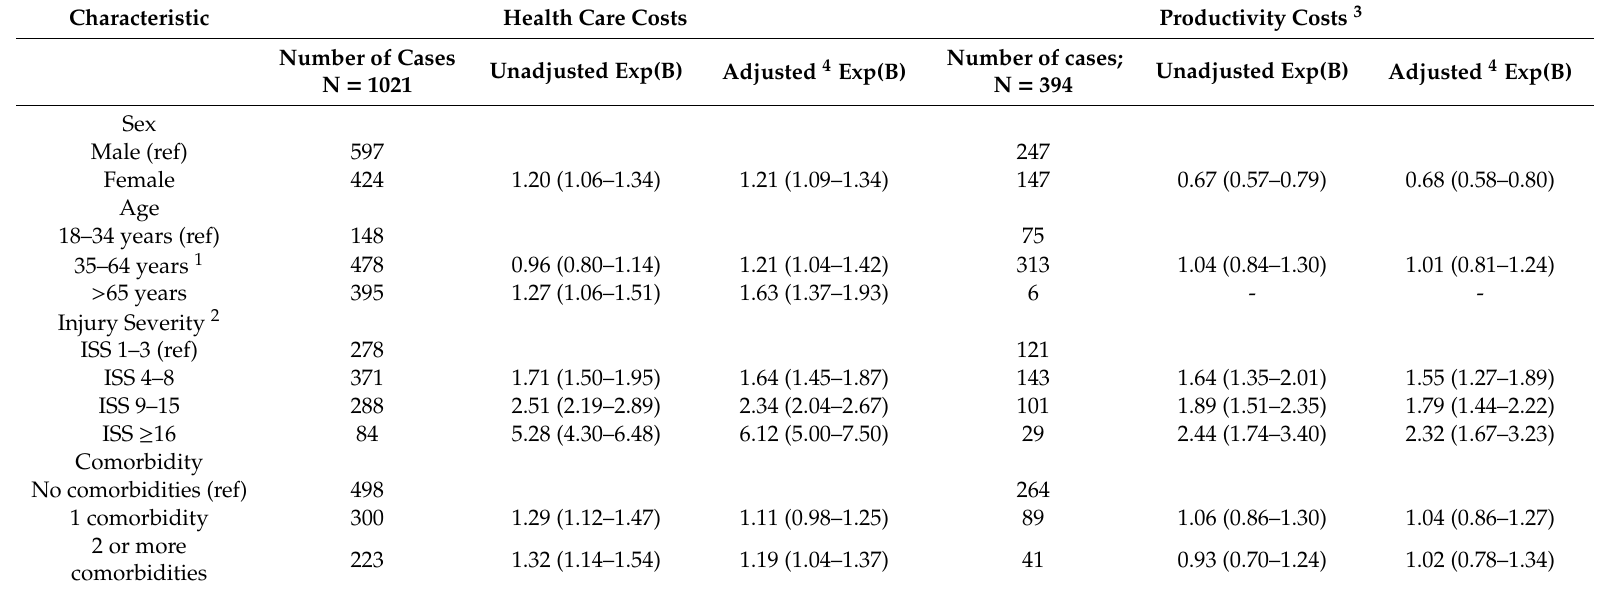
Table 3. Unadjusted and adjusted generalized linear models for health care costs and productivity